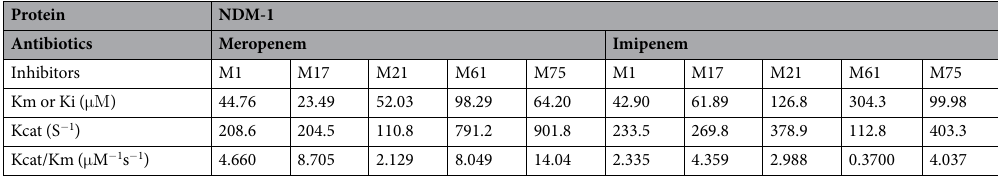
Table 6. Enzyme kinetics parameter for NDM-1 protein with substrate (Antibiotics with